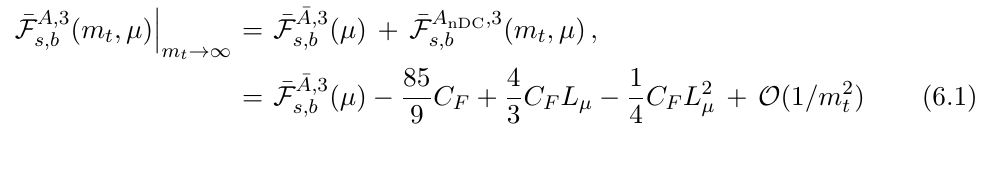
with top loop s,b